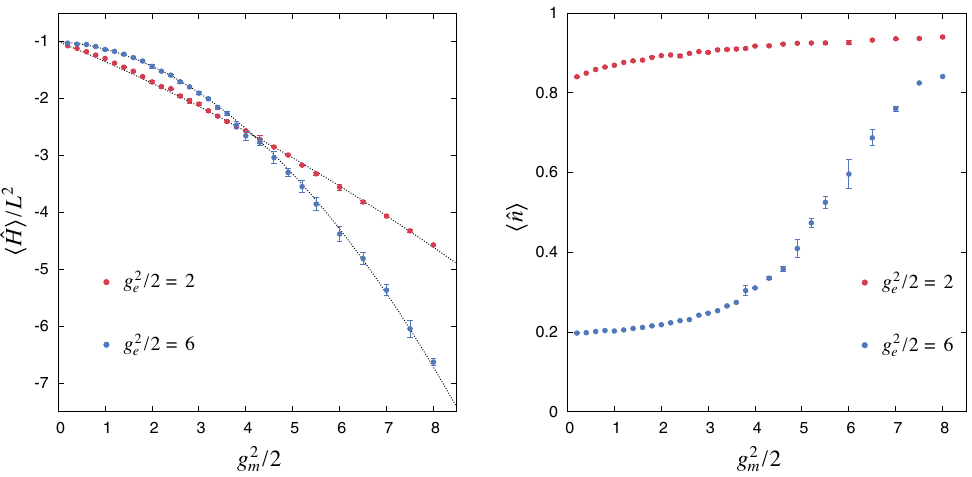
ˆ H i =L 2 density and the particle density h ˆ n i as a function of the magnetic